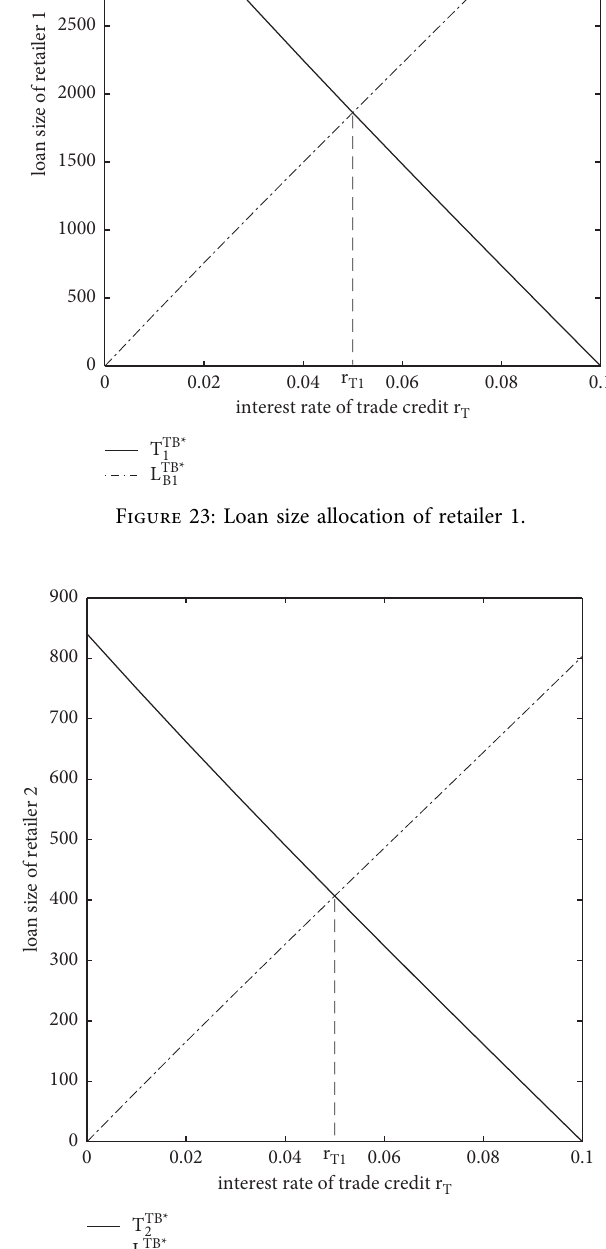
Figure 22: Impact of η M on π M .